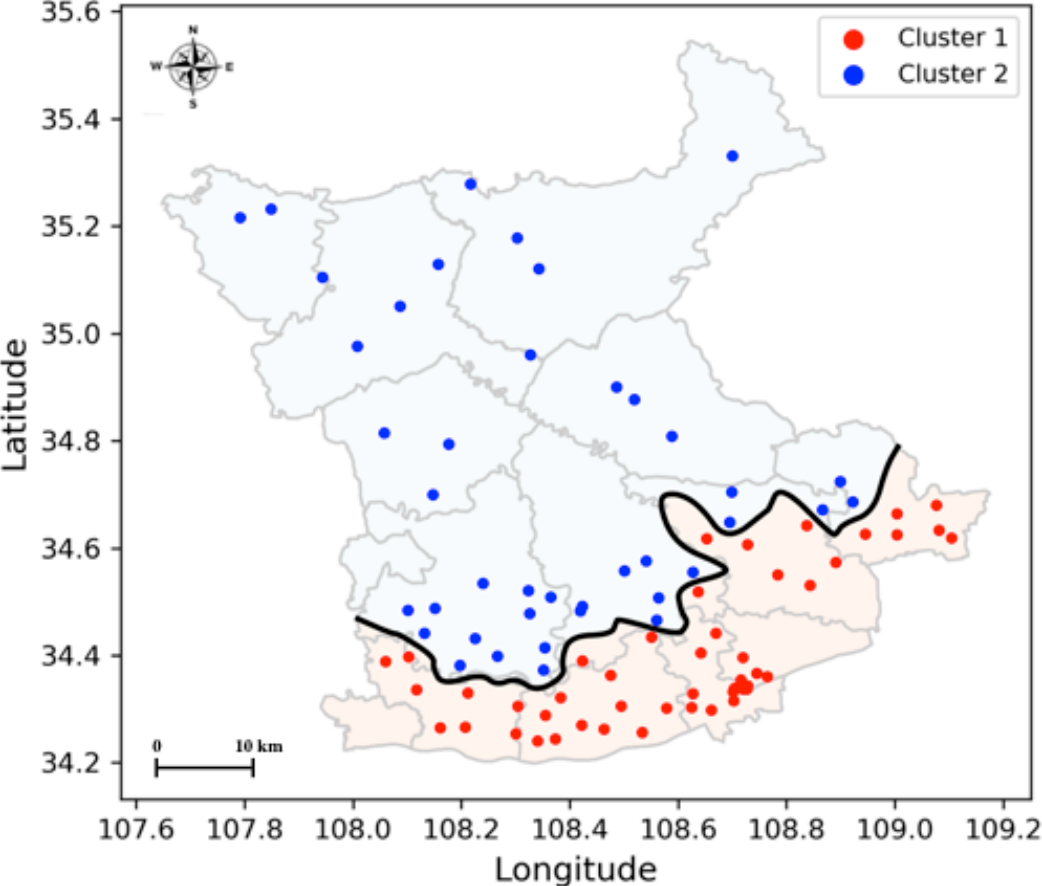
Figure 3. Smoothing boundary between these two clusters. The light red region is generated by the sites in cluster 1, and the light blue region is generated by the sites in cluster 2. The black smoothing curve was generated by Chaikin’s corner-cutting algorithm.